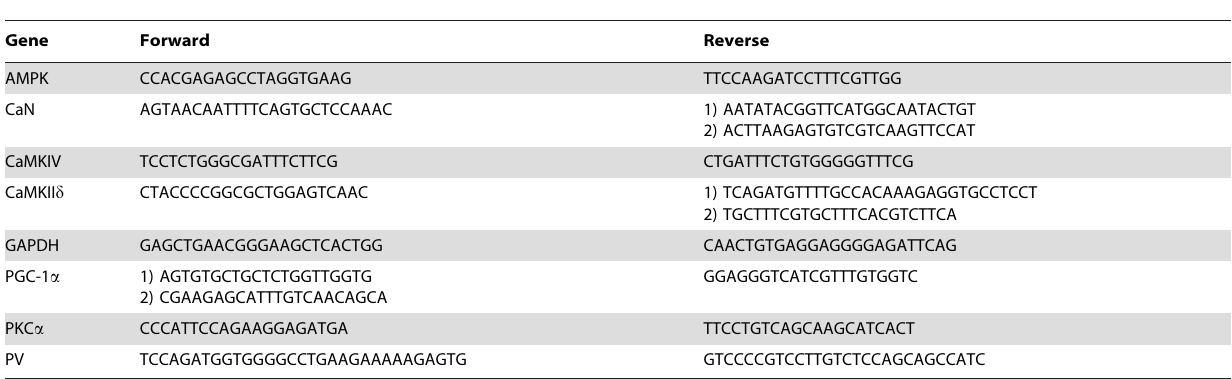
Table 1. PCR primer sequences used for